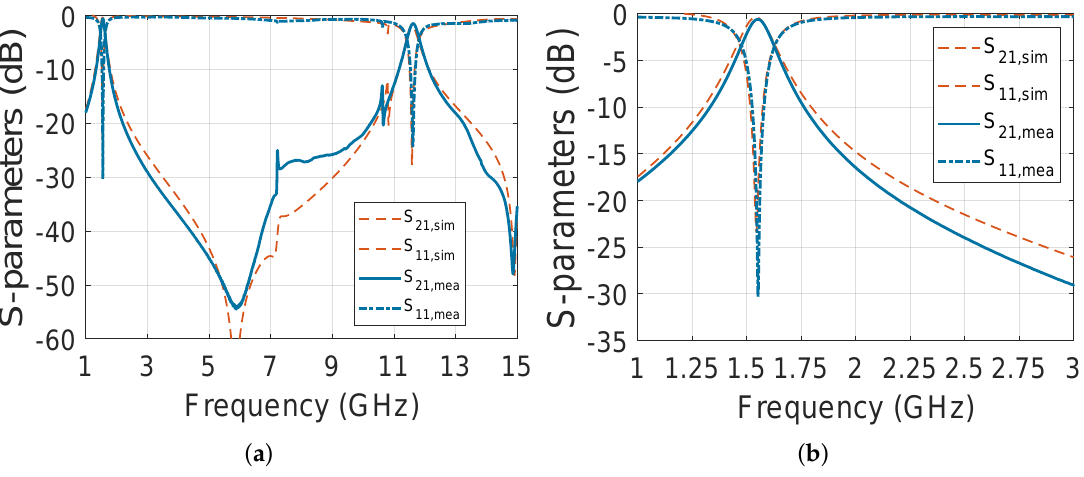
Figure 10. Measured and simulated results of the embedded coaxial SIW resonator: ( a ) wideband response up to 15 GHz and ( b ) passband of the